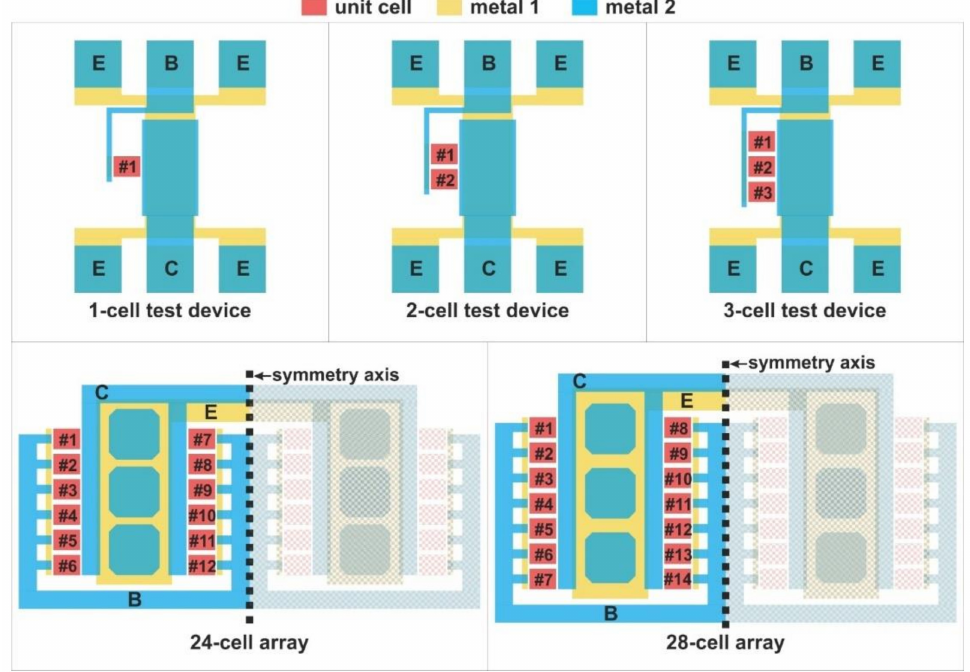
Figure 2. Schematic layouts of all the structures analyzed in this work: ( top ) 1-, 2-, 3-cell test devices; ( bottom ) 24- and 28-cell arrays. As clarified in Section 3.4, only half of the arrays (comprising 12 and 14 unit cells, respectively) was thermally and electrothermally